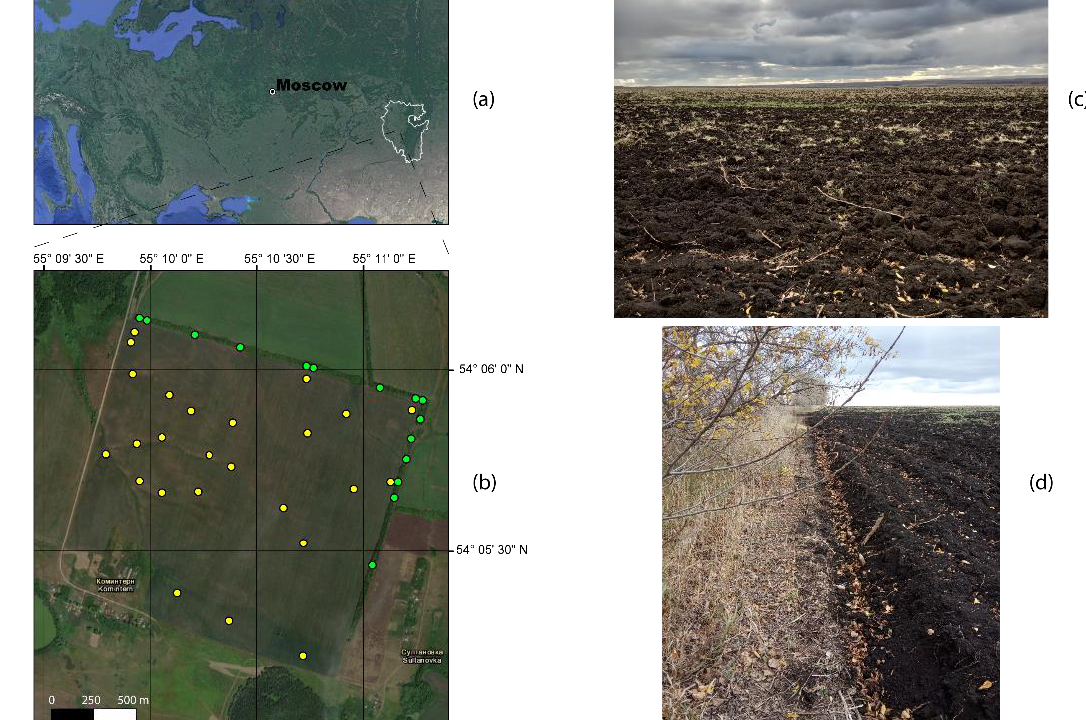
Figure 1. Maps and photos showing the location of the Republic of Bashkortostan (white boundary) ( a ); the studied arable plot location and sample points (white—arable, green—forest windbreak) ( b ); a general view of the field ( c ); and forest windbreaks ( d ). Sources: Google